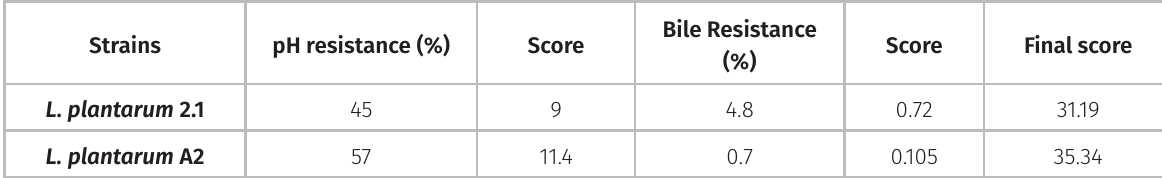
Bile Resistance Score Final (%)